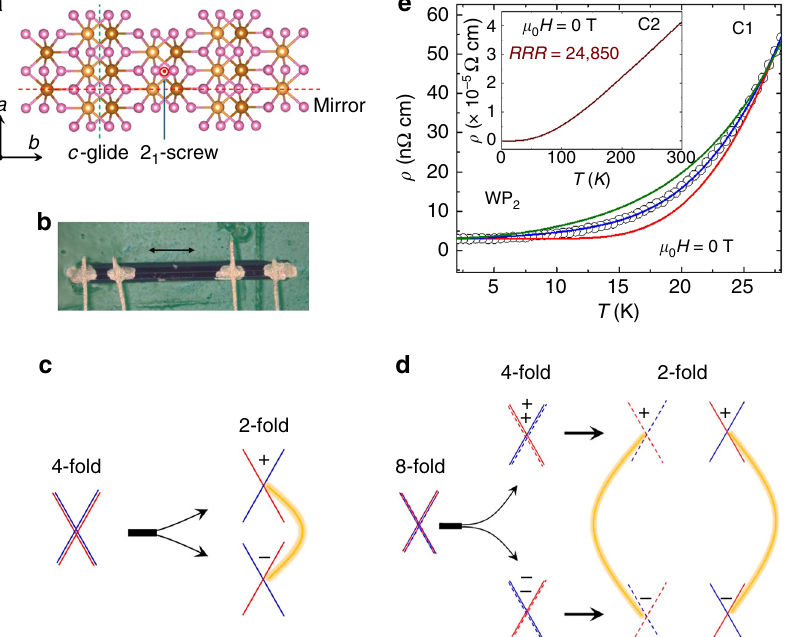
Fig. 1 Crystal structure, T -dependent resistivity and evolution of Weyl points in W/MoP 2 . a Non-symmorphic crystal structure of W/MoP 2 (W/Mo and P atoms are denoted by brown and pink spheres, respectively). For clarity, W/Mo atoms on the upper ab -plane are denoted by light brown spheres and the W/Mo atoms on the ab -plane displaced by half of the unit cell along the c-axis are denoted by dark brown spheres. Red and green dashed lines are the positions of the mirror and glide planes, respectively. Screw-axis along the c -axis is shown by red dot. b A needle shaped single crystal of WP 2 with the length, depth and width along a , b and c -axis, respectively. The scale bar is equivalent to 300 μ m. c Splitting of a four-fold degenerate Dirac point with zero Chern number into 2, two-fold degenerate Weyl points of opposite chirality upon symmetry breaking. d The neighboring Weyl points in W/MoP 2 have same chirality. This kind of Weyl point can be viewed as the splitting of an 8-fold degenerate point without inclusion of SOC. On reducing the symmetry, the 8-fold linear crossing split into a pair of 4-fold degenerate points with opposite Chern numbers of C = ± 2, which is just the overlap of two Weyl point with same chirality. SOC just lifts the overlap of two Weyl points in k -space. Since the Weyl points with opposite chirality are relatively far away from each other, they are more robust and the Fermi arcs are longer than those formed in normal Weyl semimetals. e Low temperature resistivity of WP 2 at zero magnetic fi eld. Green solid line is a fi t of the ρ ( T ) data with electron-electron scattering and electron – phonon scattering terms ( ρ ( T ) = ρ 0 + a* T 2 + b* T 5 ); red solid line is a fi t of the ρ ( T ) data with phonon drag term ( ρ ( T ) = ρ 0 + c*exp( − T 0 / T )); blue solid line is a fi t considering all the above terms ( ρ (T) = ρ 0 + a* T 2 + b* T 5 + c*exp( − T 0 / T )). The inset shows ρ ( T ) data of crystal with RRR =